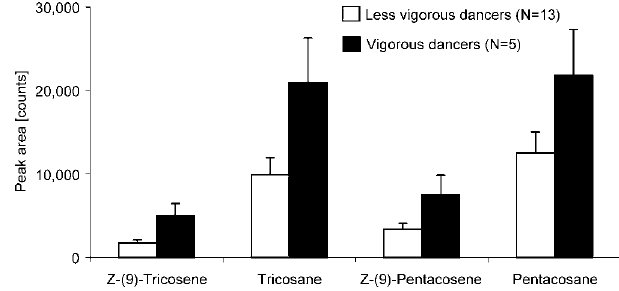
Figure 3. Comparison of Vigorous and Less-Vigorous Dancers The relative abundance for Z-(9)-tricosene, tricosane, Z-(9)-pentacosene, and pentacosane tended to be higher for vigorous ( n ¼ 5, black bars) than less-vigorous ( n ¼ 13, white bars) dancers. Vigor of dancing was assessed subjectively by one experimenter and included appearance of abdomen movement and the rate of waggle runs. More vigorous dancers appeared to move their abdomen farther to the side and perform more waggle runs than less-vigorous dancers. Error bars represent the standard error. Statistical tests are given in the